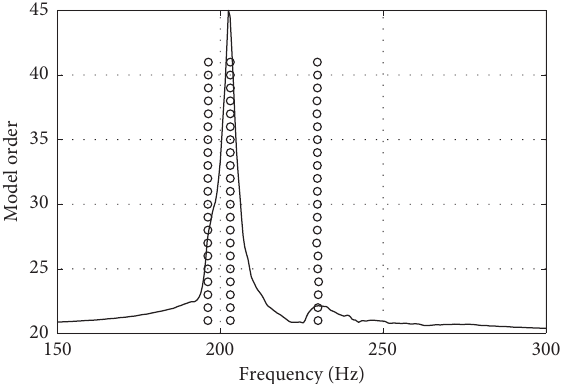
Figure 21: Variation of the identified frequencies (below 400Hz) with model order for damage case ②